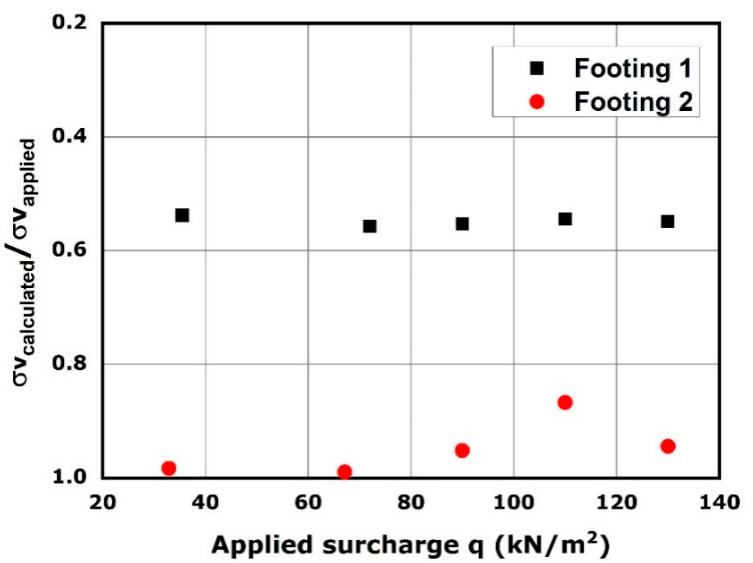
Figure 5. Vertical stress ratio at stone column base level for Footings 1 and 2 (drained conditions).